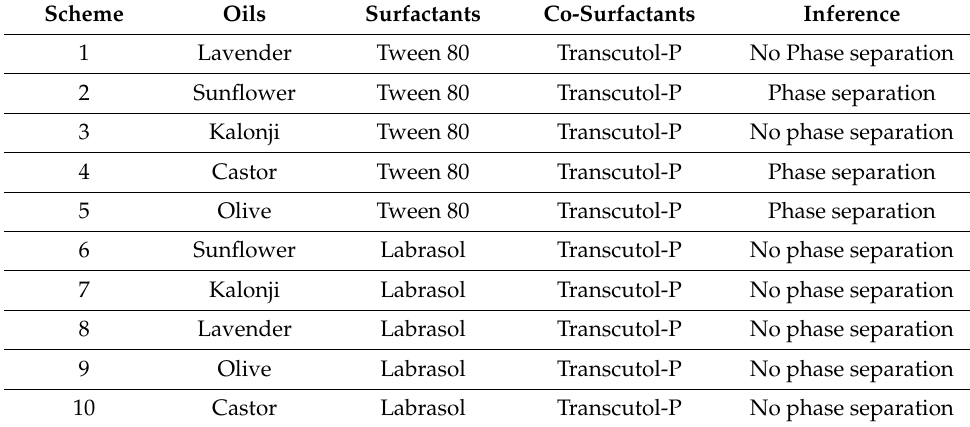
Figure 1. TQ solubility in various surfactants, co-surfactants, and oils. Table 1. Screening of Oils, Surfactants, and Co-Surfactants Based on Miscibility.